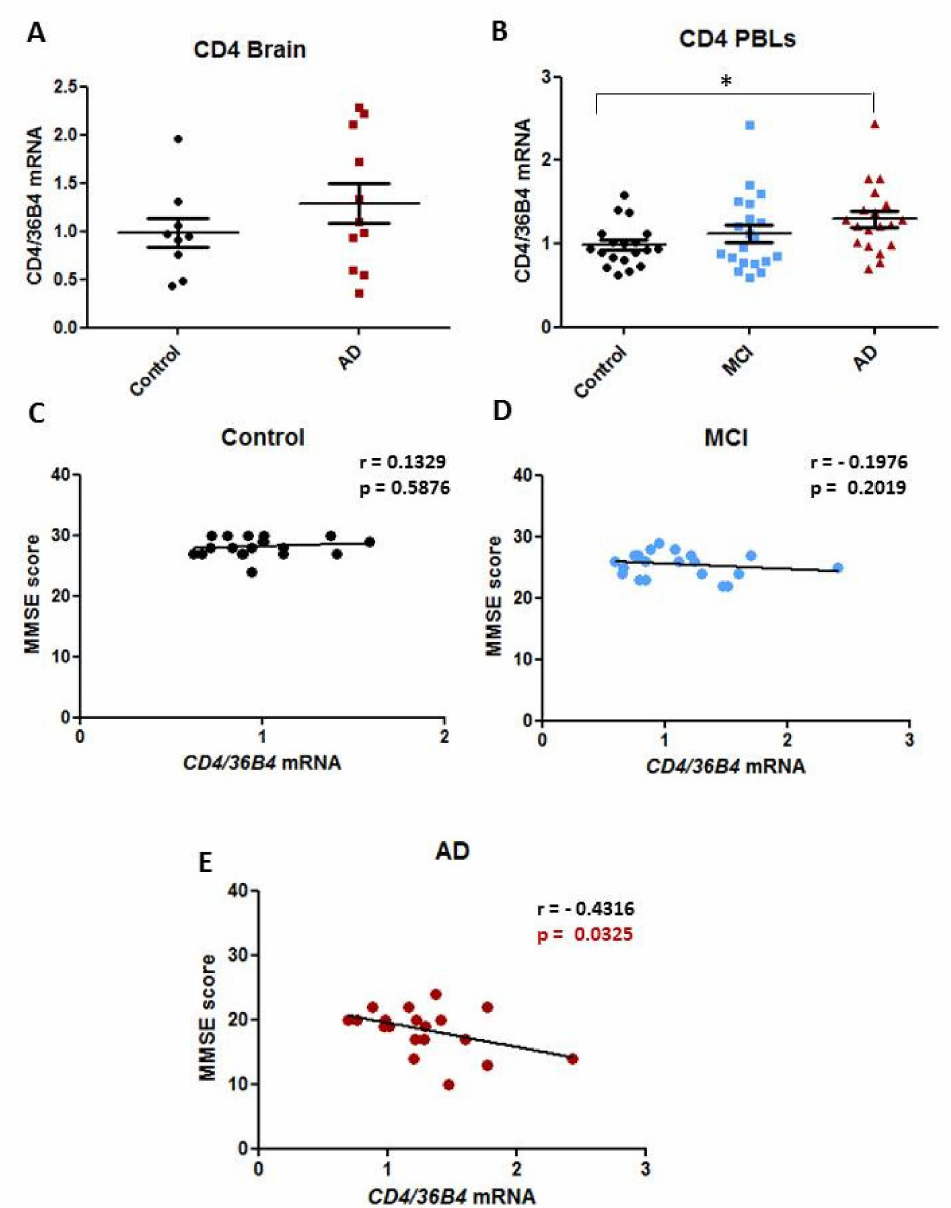
Figure 3. Expression levels of CD4 mRNA in human AD samples. ( A ) Temporal cortex CD4 mRNA levels detected by qRT-PCR in samples of AD patients and their respective controls. ( B ) CD4 mRNA levels detected by qRT-PCR in PBMCs samples from a cohort of AD and MCI individuals and their age-matched controls (* p ≤ 0.05; Kruskal-Wallis test, Control vs. AD). ( C – E ) Correlations between CD4 mRNA levels and MMSE score in control ( C ), MCI individuals ( D ), and AD